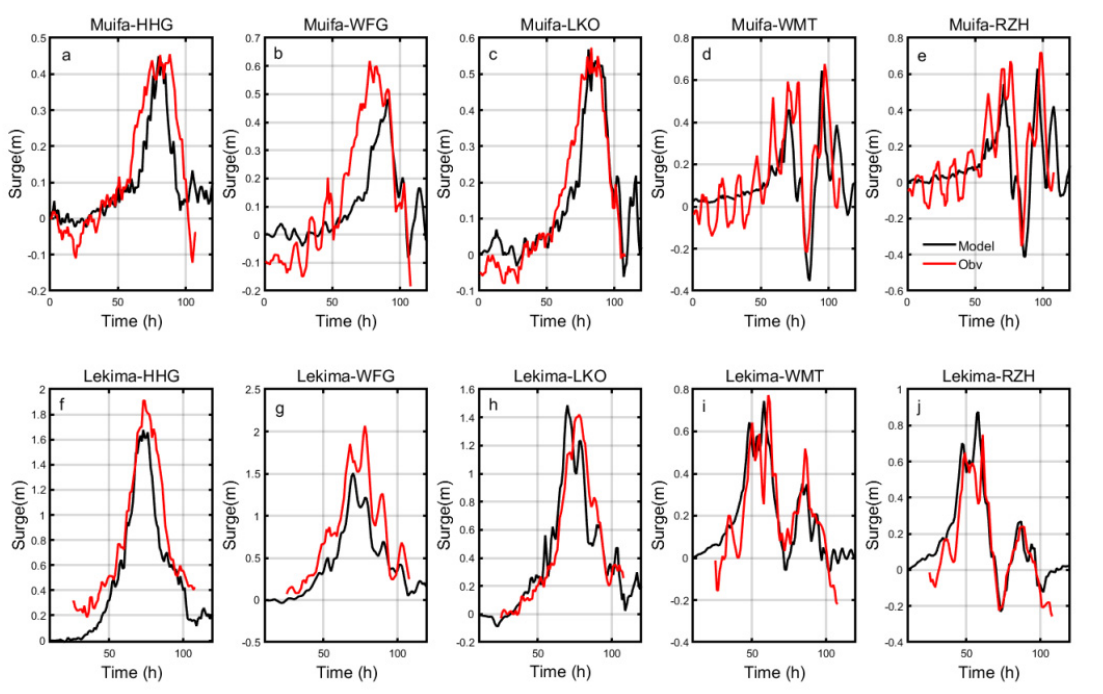
Figure 6. Simulation and observations of the storm surge of Typhoon Muifa ( a – e ) and Typhoon Lekima ( f – j ) at stations ( a , f ) HHG, ( b , g ) WFG, ( c , h ) LKO, ( d , i ) WMT, and ( e , j ) RZH. The red line represents observations, and the black line represents simulations calculated with the SWAN + ADCIRC model. Table 4 lists the absolute error and relative error between the observed data and ERA5 data on wind speed. The absolute error and relative error were calculated from the equation shown below: